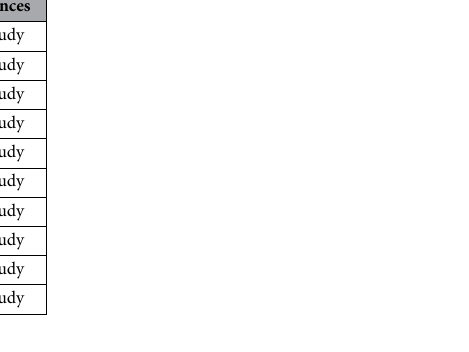
Table 3. Primer sequences used for qPCR